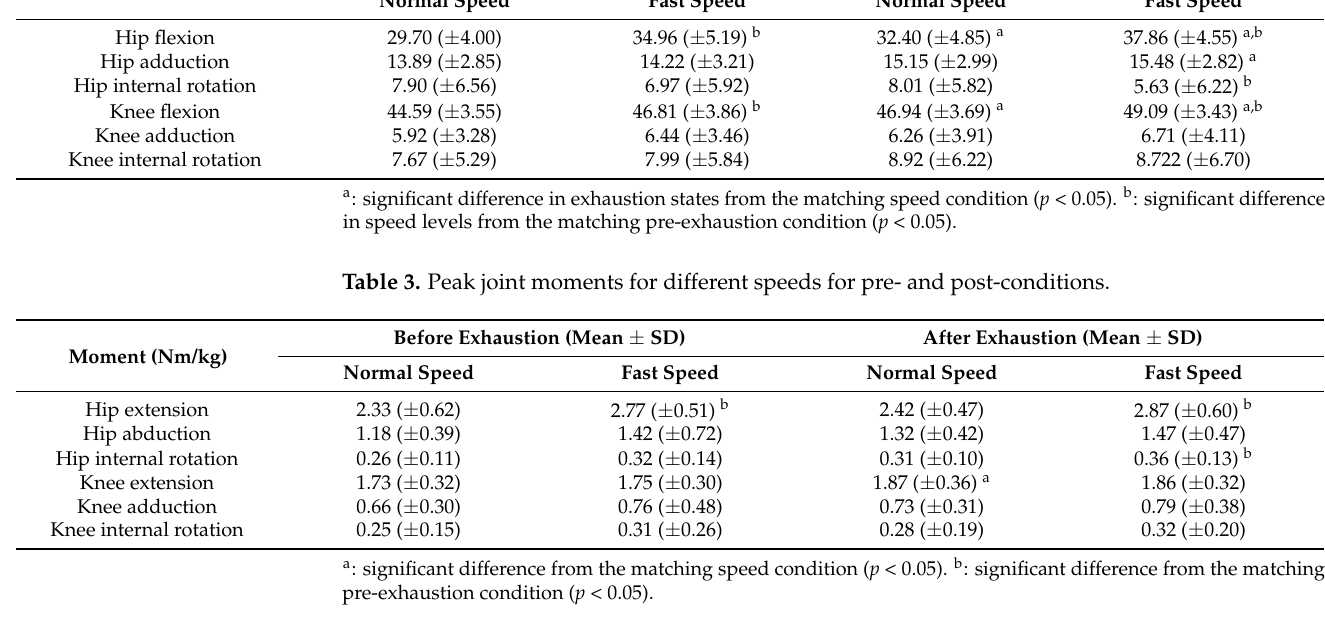
Table 4. Peak ITB strain and strain rate for different speeds for pre- and